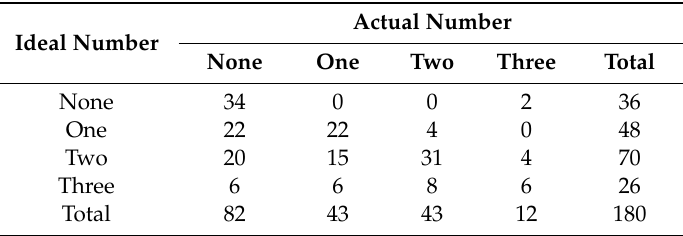
Table 3. Distribution of the di ff erence between the ideal and actual number of children.